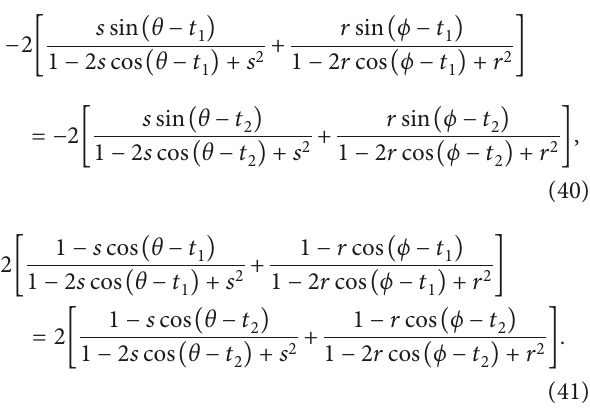
Figure 4: Graphs h Example